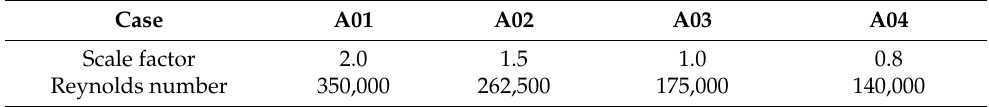
Table 3. Scale factor and the corresponding Reynolds